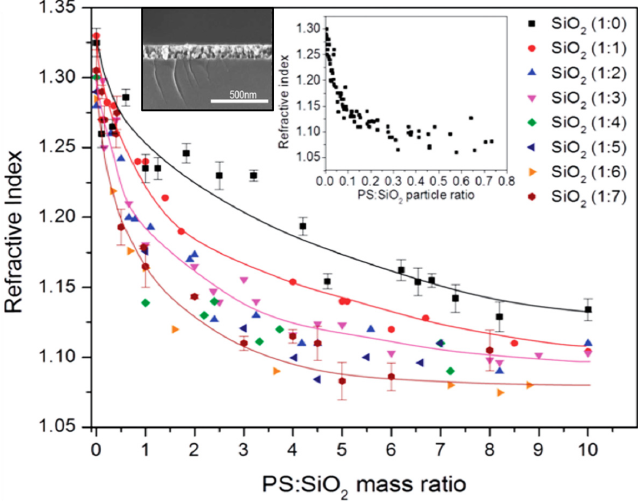
Figure 5. The index trend of SiO 2 nanoparticle films with increasing polystyrene solution mass ratio. There are two distinct trends, a sharp decrease in index with minimal introduction of PS, and a gradual decrease in index with significant introduction of PS. Inset: the refractive indices as a function of the estimated PS–SiO 2 particle ratio. Reproduced from [13] (copyright permission). The other inset shows the cross ‐ sectional SEM image of the void filled silica particle film.